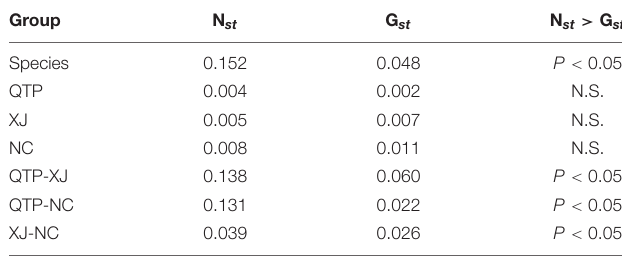
TABLE 6 | Detection of a phylogeographic structure based on N st and G st